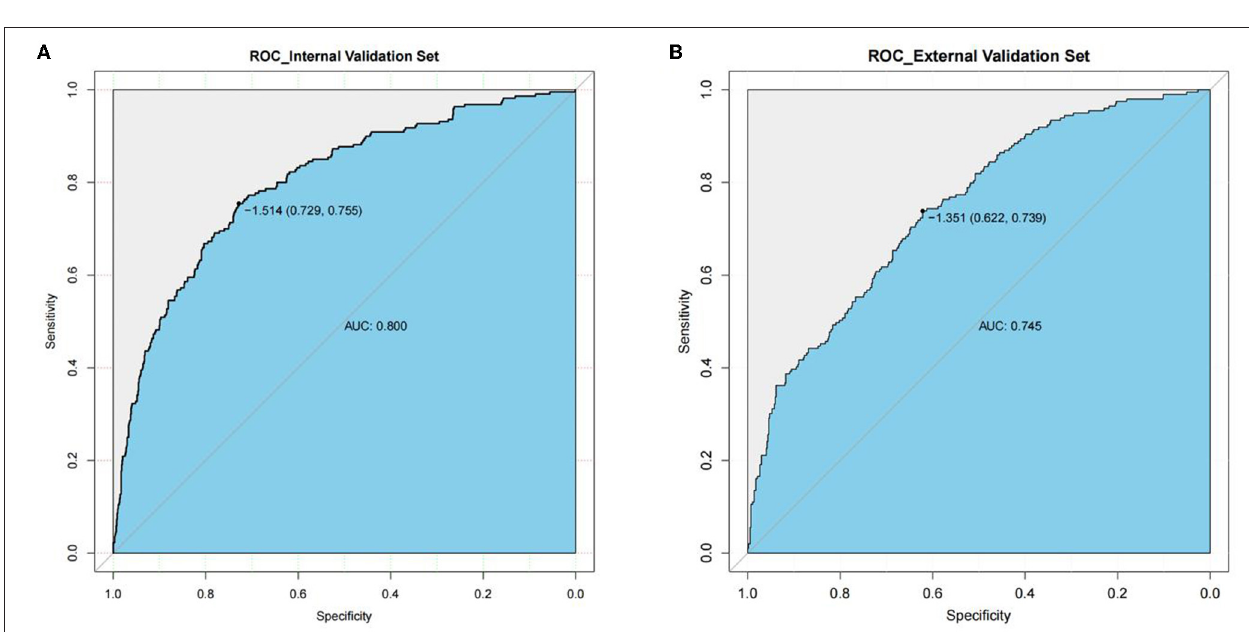
FIGURE 3 | AUC of the ROC curve in internal validation set and external validation set. Internal validation set (A) , and external validation set (B) . The y axis means the true positive rate of the risk prediction of decompensated cirrhosis patients with spontaneous bacterial peritonitis. The x axis means the false positive rate of the risk prediction of decompensated cirrhosis patients with spontaneous bacterial peritonitis.